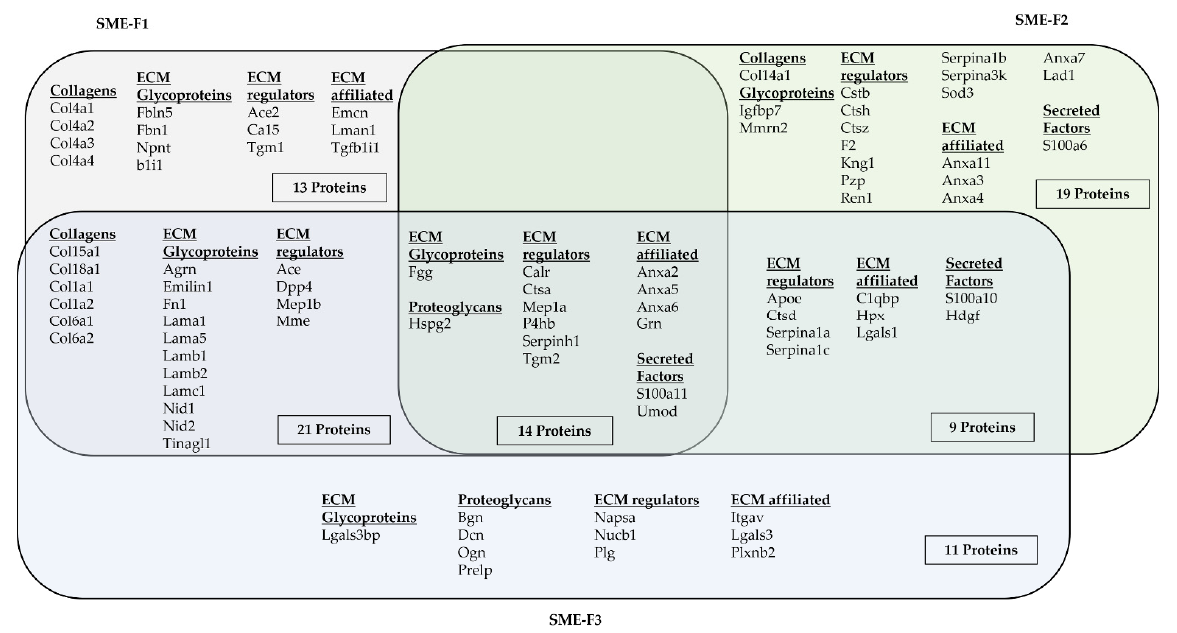
Figure A4. Quantified matrisome proteins in fractions of SME. Venn diagram illustrates the common and unique matrisome proteins in each fraction. Matrisome proteins were classified as collagens, ECM glycoproteins, proteoglycans, ECM-affiliated, ECM regulators and secreted factors.